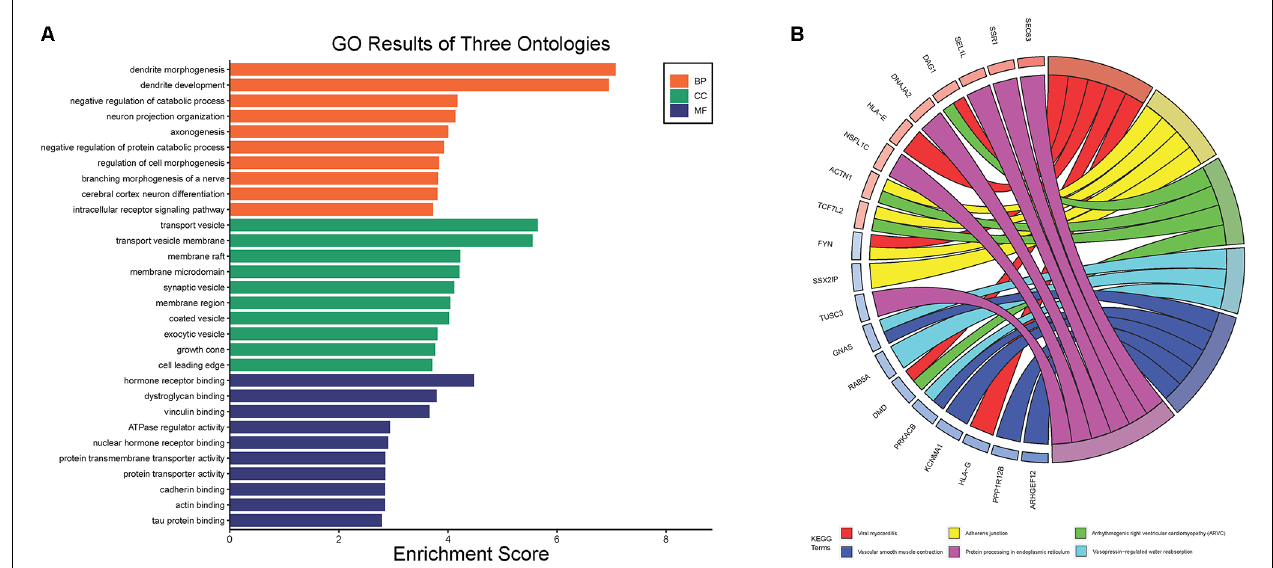
FIGURE 4 | The Go terms and KEGG pathways enrichment analysis of 226 DEGs in PD. (A) The Go terms conclude the biological process, cellular component, and molecular function. (B) KEGG pathway revealed that DEGs were remarkably concentrated in the viral myocarditis, adherens junction, arrhythmogenic right ventricular